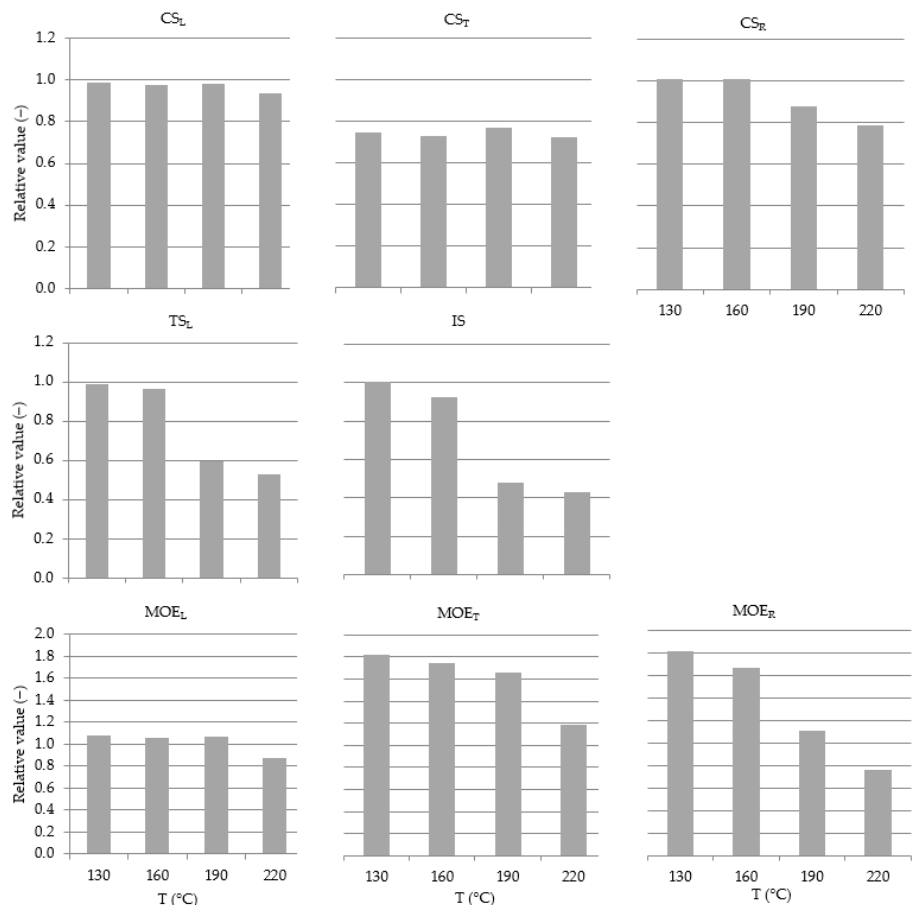
Figure 4. Relation-to-control value (in proportion) versus T (°C). Each column represents the mean value of n samples. IS, n = 20; CS L , n = 10; CS T , n = 10; CS R , n = 10; TS L , n = 10; MOE L , n = 10; MOE T , n = 10; MOE R , n = 10.